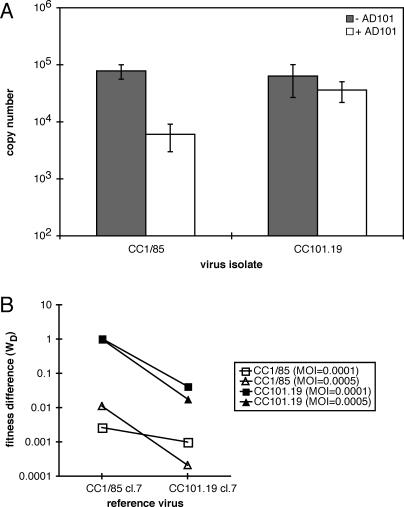
Replication and Replicative Fitness of the CC1/85 and CC101.19 Isolates(A) PBMC cultures were singly infected with the indicated isolates at an MOI of 0.0005 in the presence (open bars) or absence (shaded bars) of 1 μM AD101. The vifX vif probe was used in the TaqMan QPCR assay to derive the copy number per QPCR reaction; the values shown are the means ± SEM from three independent experiments.(B) The fitness differences of the isolates CC1/85 (open symbols) or CC101.19 (filled symbols) as detected by the vifX probe are shown relative to the indicated vifY reference viruses at MOIs of 0.0001 (squares) or 0.0005 (triangles). The values are derived from the mean virus proportions from three independent experiments.